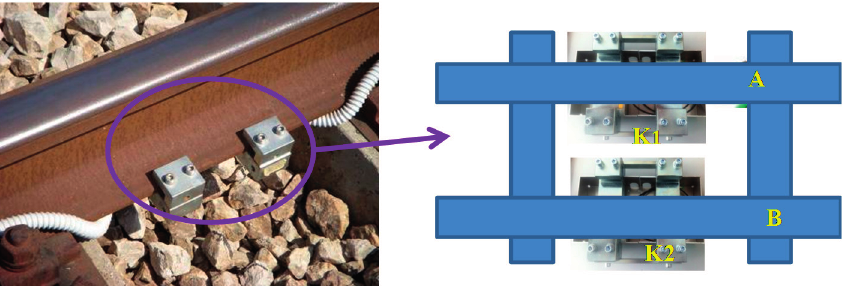
Figure 3. Packages containing the FBG accelerometer positioned under the rail track. Inset: Schematization of the rail track with the two FBG accelerometers fixed under the rails and labeled K1 and